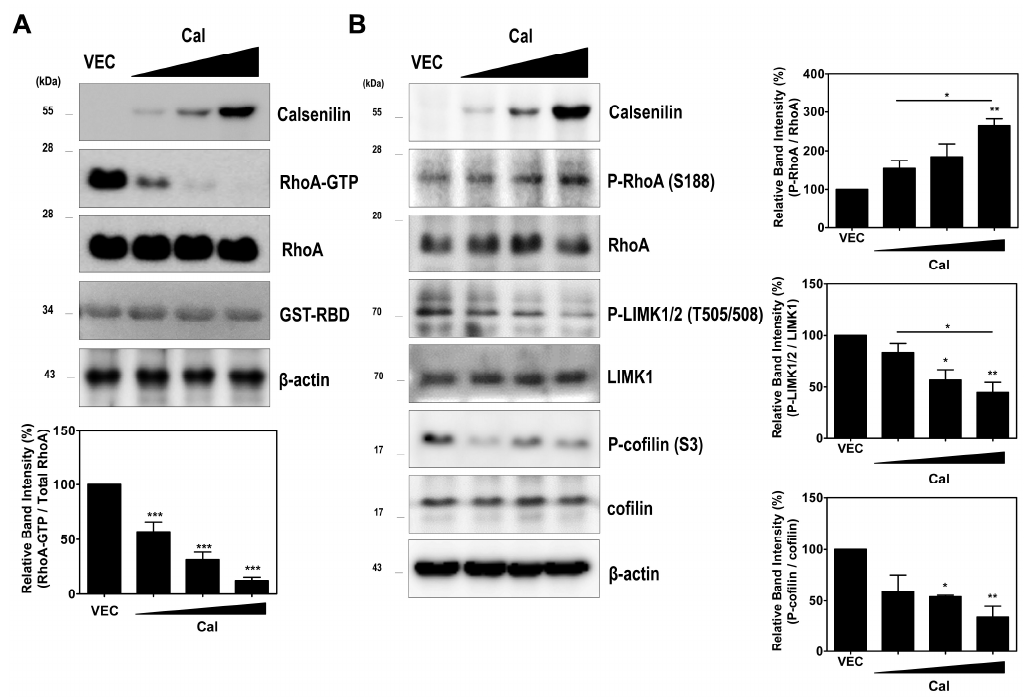
Figure 2. Calsenilin regulates RhoA inactivation and the RhoA-ROCK-LIMK-cofilin pathway. ( A ) PC12 cells were transiently transfected with calsenilin in a dose-dependent manner. After 24 h, the cells were lysed, and RhoA-GTP was detected by GST-Rhotekin-RBD pull-down assay; ( B ) Phosphorylation levels of RhoA, LIMK1/2, and cofilin in PC12 cells expressing calsenilin were analyzed by Western blotting. Statistical differences were determined by one-way ANOVA test with Tukey’s post hoc test ( n = 3, * p < 0.05; ** p < 0.01; *** p < 0.001).